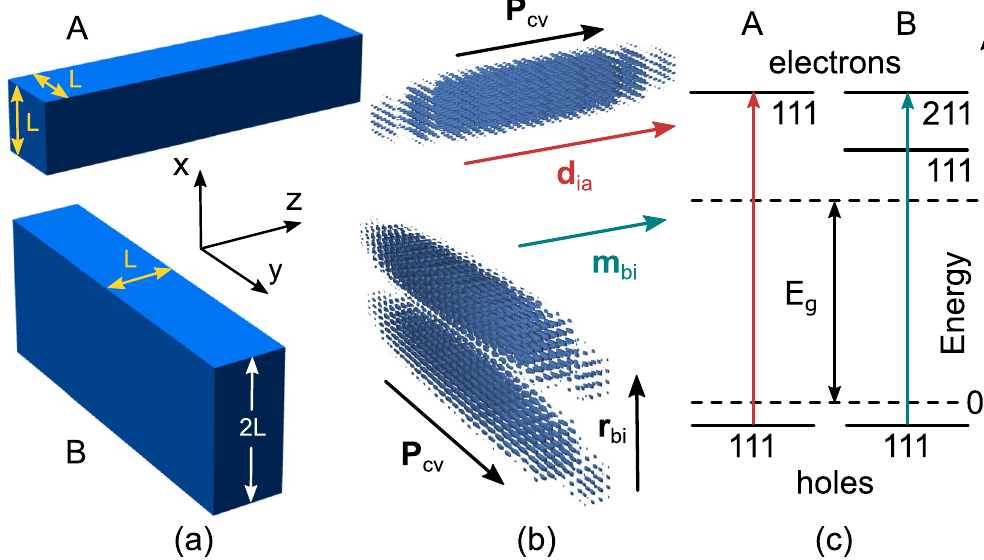
Figure 3. Schematic of (a) nanorods A and B, (b) wave functions of electronic states |111 〉 and |211 〉 , electric and magnetic dipole moments of interband transitions, and (c) energy-level diagrams of the considered transitions; E g is the bandgap of bulk